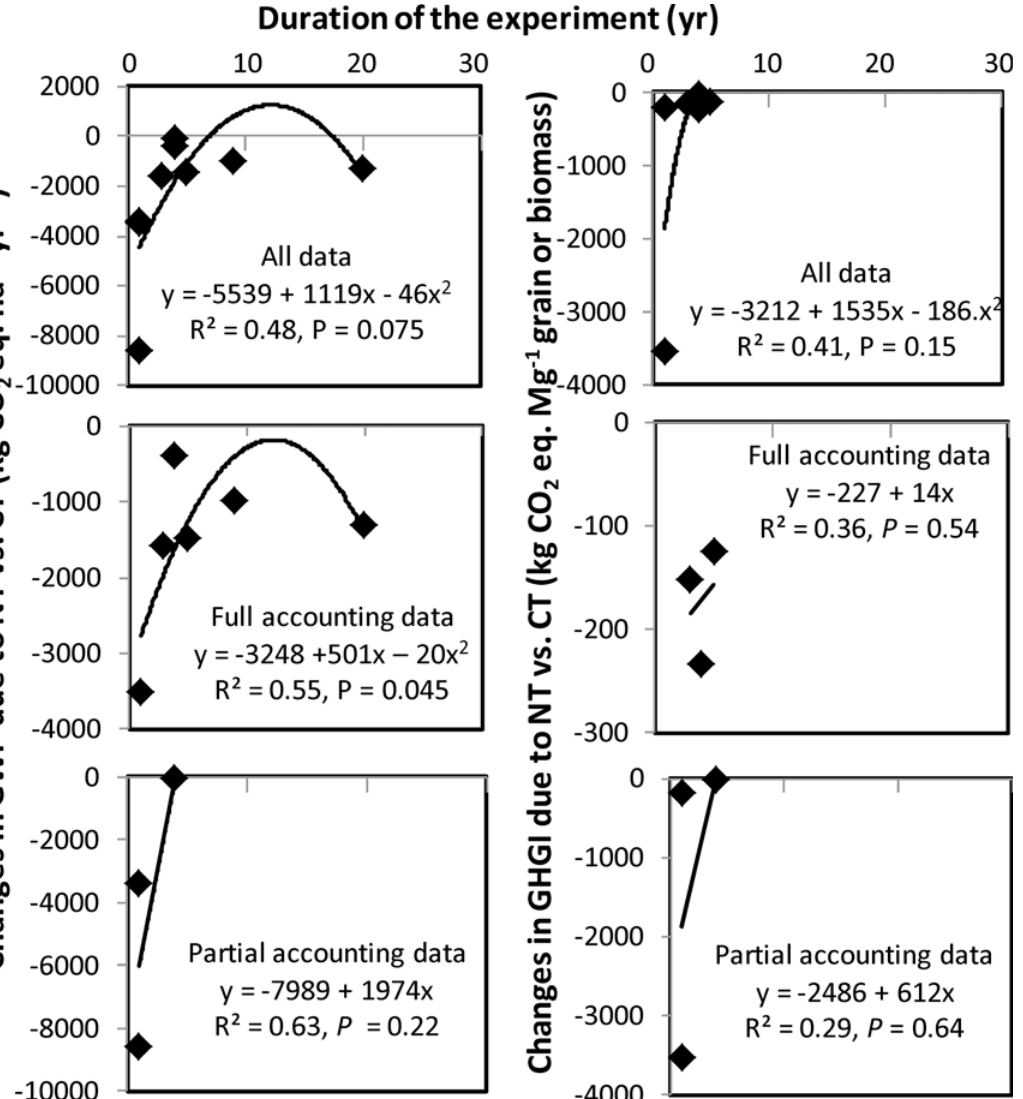
Fig 2. Changes in net global warming potential (GWP) and greenhouse gas intensity (GHGI) due to no-till (NT) vs. conventional till (CT) with the duration of the experiment using the soil organic C method. Full accounting data denote calculations of GWP and GHGI by accounting all sources and sinks of CO 2 (N 2 O and CH 4 emissions, farm operations, inputs, and soil C sequestration) and Partial accounting data, partial accounting of sources and sinks (N 2 O and CH 4 emissions and/or soil C sequestration). All data denotes inclusions of full and partial accounting